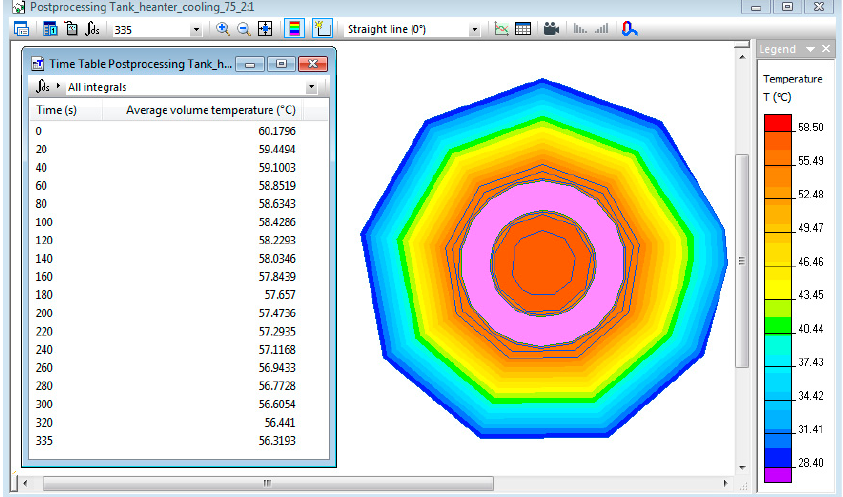
Figure 16. The cooling process for 335 s and the AMD ferrite ring temperature distribution at the end of the cooldown process.